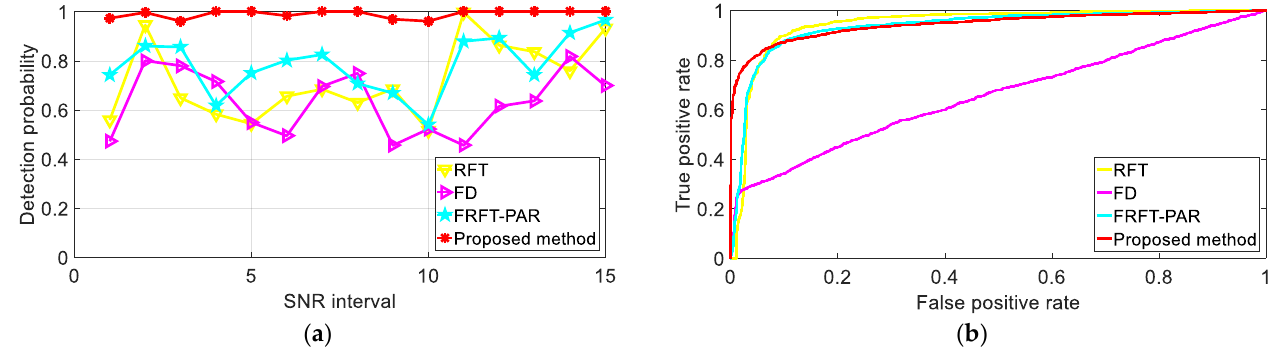
Figure 17. Target detection probability (observation time 2.048 s). ( a ) Detection rates of different algorithms. ( b ) ROC curves of different algorithms. Table 4. Average detection probabilities of the detectors on the 20 datasets at four polarizations. Observation Time(s)